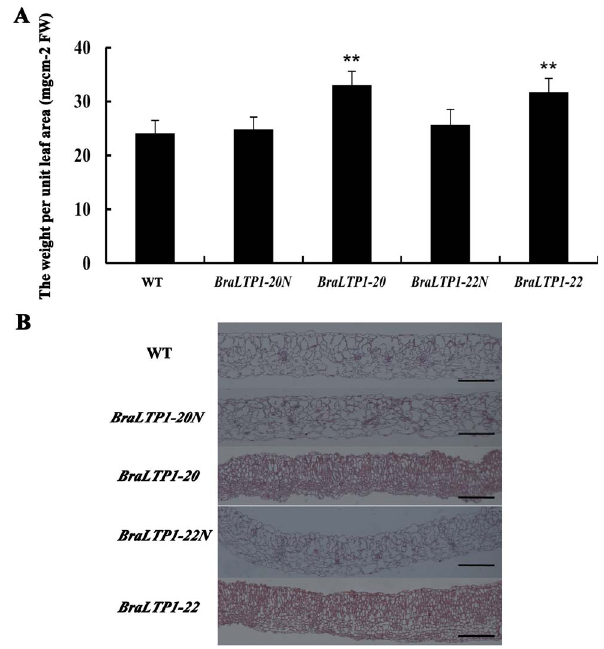
Figure 7. Overexpression of BraLTP1 promotes cell prolifera- tion. (A) The weight of per unit leaf area of wild type (WT), BraLTP1 -20 and BraLTP1 -22 and their segregated negative controls BraLTP1 -20N and BraLTP1 -22N. Leaf disks were collected from the fourth fully- expanded leaf from the apex taken from 8-week-old plants. Data are the mean 6 SD from three independent experiments using leaves of five plants. **Significant differences at the levels of P , 0.01. (B) Represen- tative leaf cross-sections of segregating 35S::BraLTP1 and WT plants. The fourth fully-expanded leaf from the apex were taken from 6-week old plants of WT, 35S::BraLTP1 transgenic plants ( BraLTP1 -20 and BraLTP1 - 22), and null segregates of these two lines ( BraLTP1 -20N and BraLTP1 - 22N). The experiments were repeated for 3 times. Bar=200 m